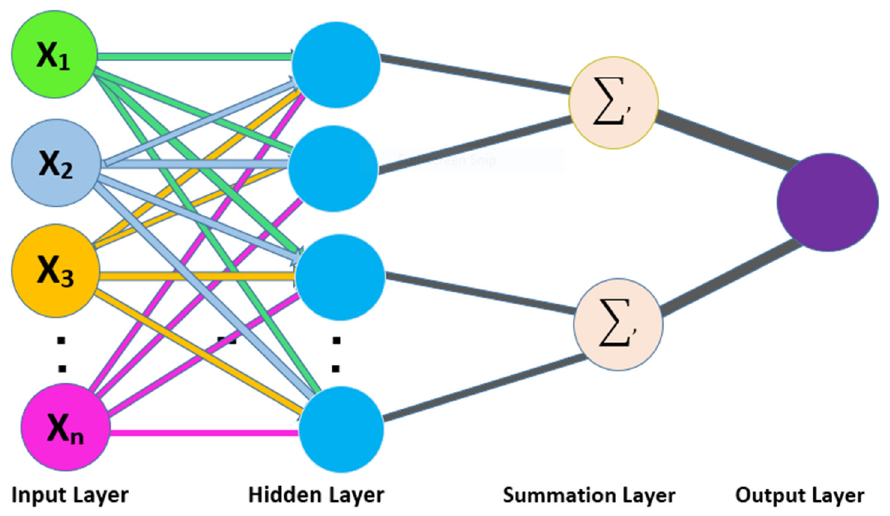
Figure 3. Schematic view of PNN.